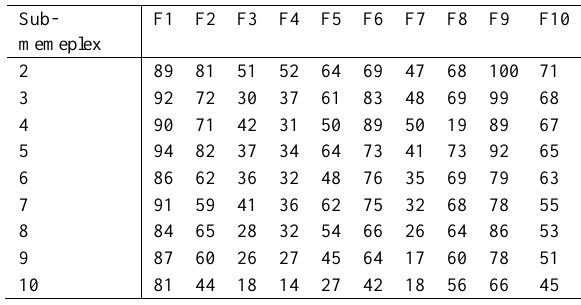
Table 8. Number of successful runs for different sub- memeplex size(q).